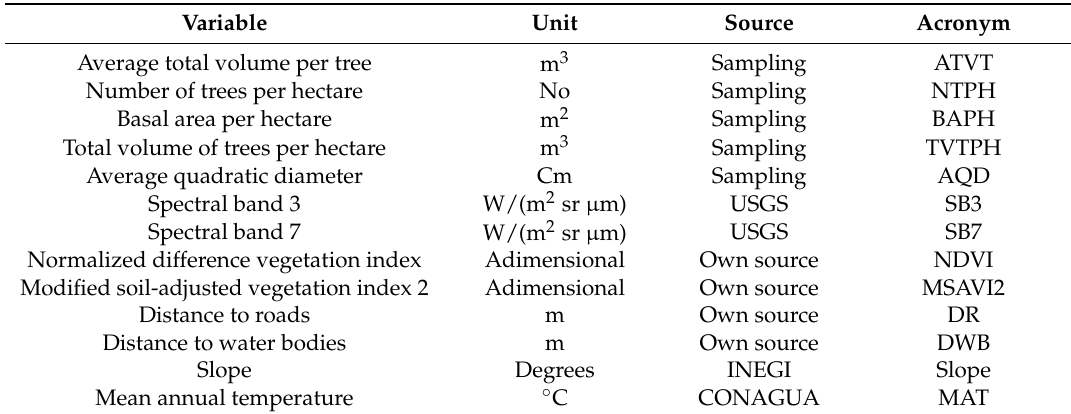
Table 1. Variables used in the data